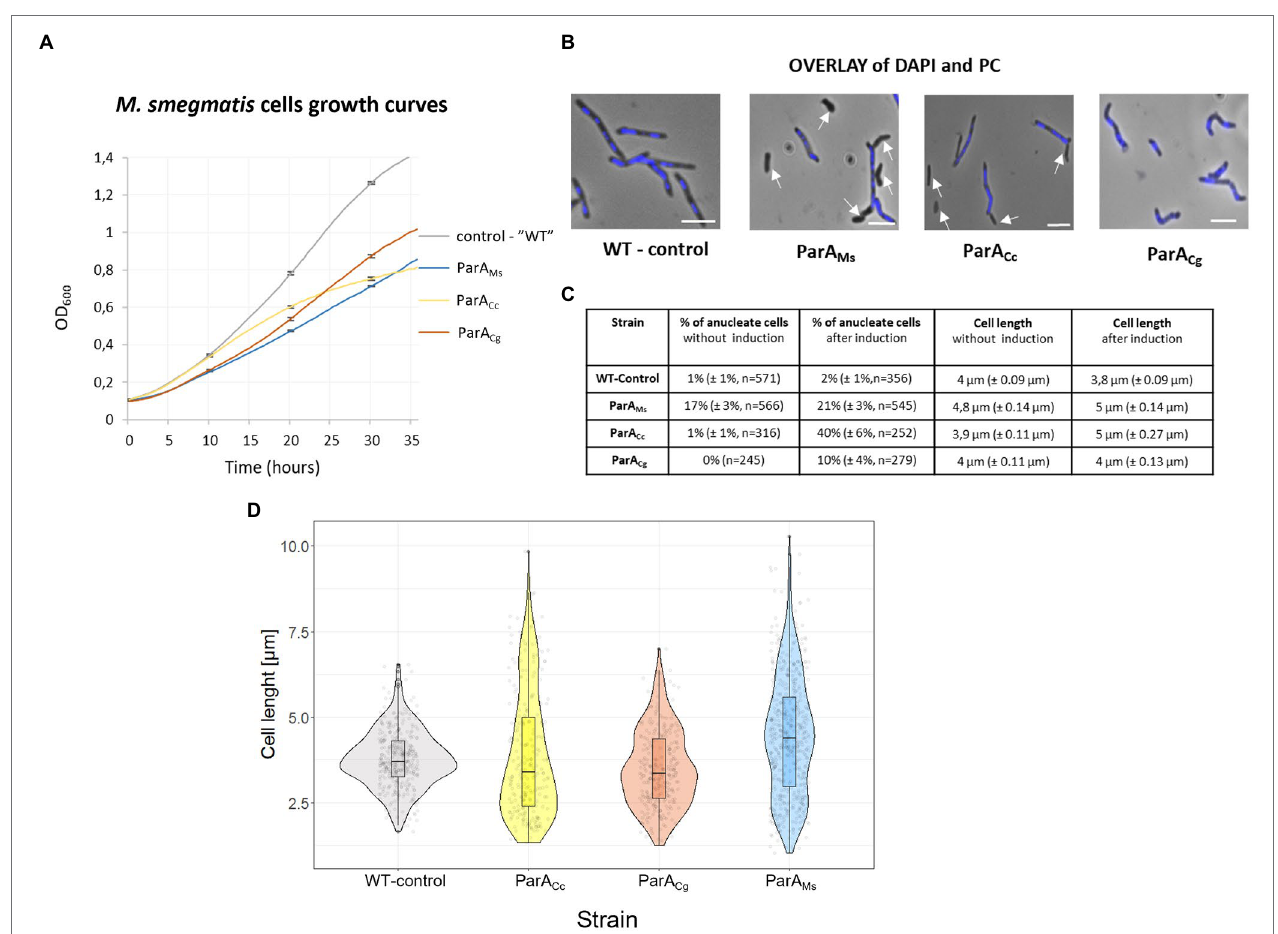
FIGURE 5 | The negative effects of overproduction of the endogenous and heterologous ( C. crescentus and C. glutamicum ) ParA on M. smegmatis growth and cell morphology. (A) M. smegmatis culture growth rate of strains overproducing the endogenous (ParA Ms ), C. crescentus (ParA Cc ), and C. glutamicum ParA (ParA Cg ). parA was overexpressed from the parA gene (the additional gene copy under the p ami promoter in the pMV vector in the wild type background) induced with 1% acetamide. M. smegmatis WT with empty vector pMVp ami served as a control. The results represent the average of three independent experiments obtained using a Bioscreen C instrument. Bars indicate SEs. (B) M. smegmatis cells overproducing endogenous (ParA Ms ), C. crescentus (ParA Cc ), or C. glutamicum ParA (ParA Cg ; as descried above). Phase contrast images are merged with blue fluorescence of nucleoids stained with DAPI. WT with empty vector pMVp ami served as the control. Scale bar: 3 μ m. Arrows indicate anucleate cells. (C) Chromosome content and cell length of M. smegmatis cells overproducing endogenous (ParA Ms ), C. crescentus (ParA Cc ), or C. glutamicum ParA (ParA Cg ; as descried above) with and without overnight induction of 1% acetamide. M. smegmatis WT with empty vector pMVp ami served as a control. Cell length was measured only in cells possessing DNA (stained with DAPI). The experiment was performed in two independent biological replicates. The number of calculated cells is indicated as n . The 95% of CI was indicated as ±. (D) Violin plot showing the length of M. smegmatis cells overproducing their endogenous (ParA measured in all cells (with and without